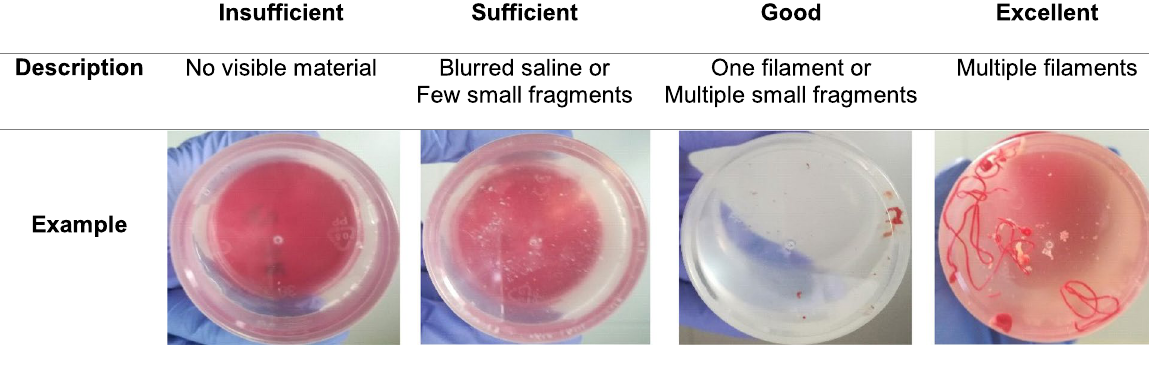
Table 1 Macroscopic evaluation of EBUS-TBNA samples